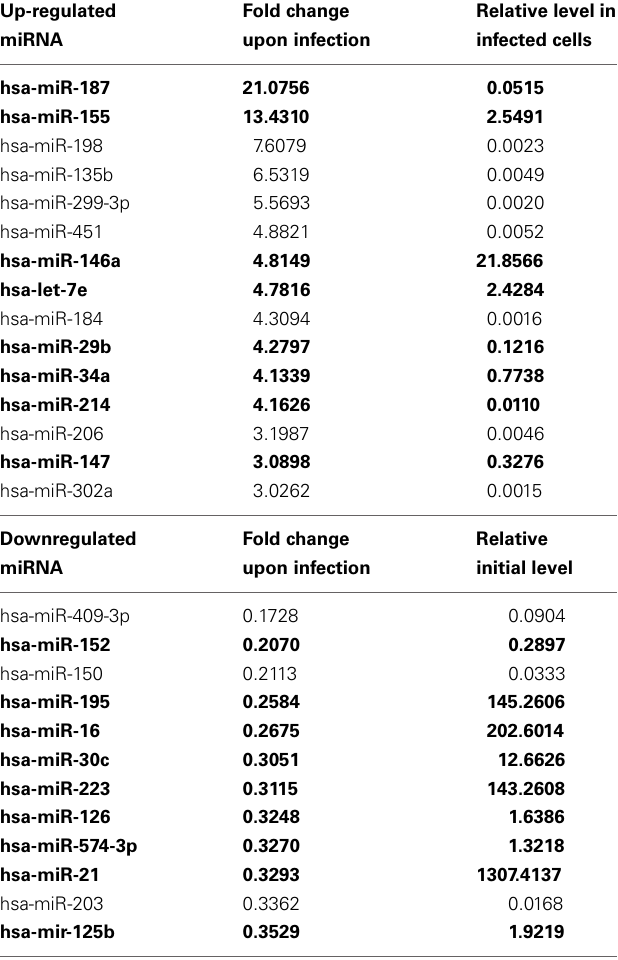
Table 1 | miRNA differentially regulated in H. pylori B38-activated dendritic